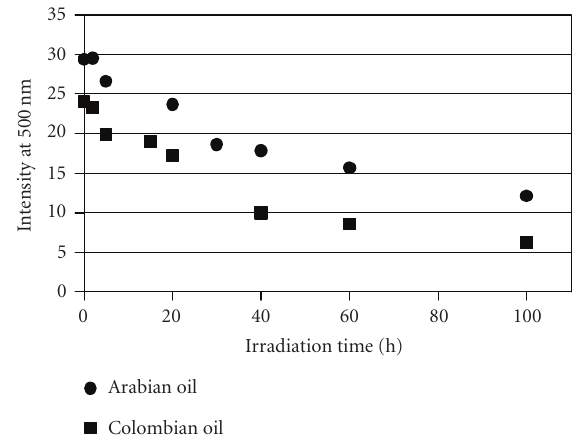
Figure 6: Fluorescence intensity at 500 nm versus sunlight irra- diation time. Circles represent Arabian oil and squares represent Colombian